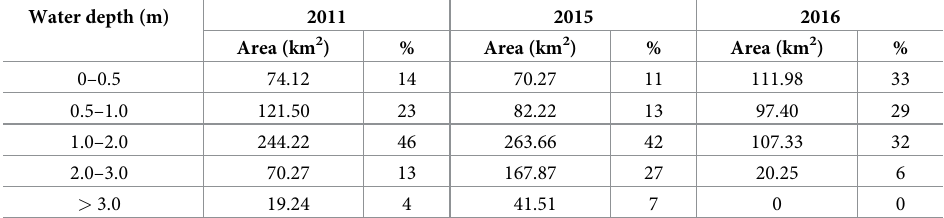
Fig 7. Comparison of flood extent areas: (a) model simulation and observed (MSI) for the 2015 flood event and (b) model simulation and observed (MODIS) for the 2016 flood event. https://doi.org/10.1371/journal.pone.0224558.g007 Table 2. Potential flood inundated area with different water depth in three flooded years.